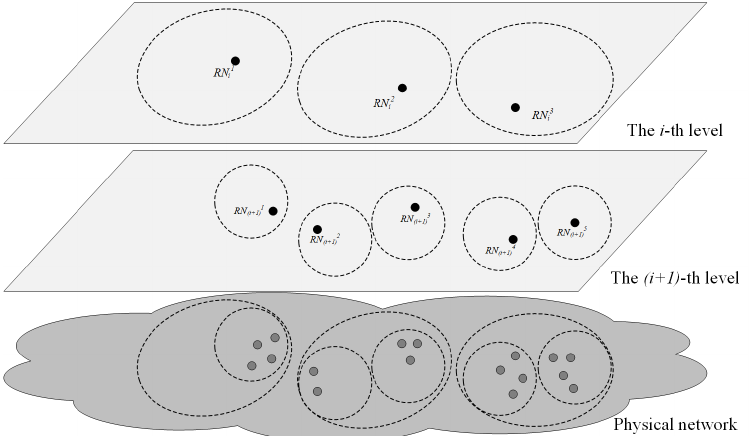
Figure 1. Service area inclusive relationship among name resolution nodes in higher and lower levels of LNMRS. A resolution node in higher levels maintains a larger service area, which is consisted of the service areas of its children